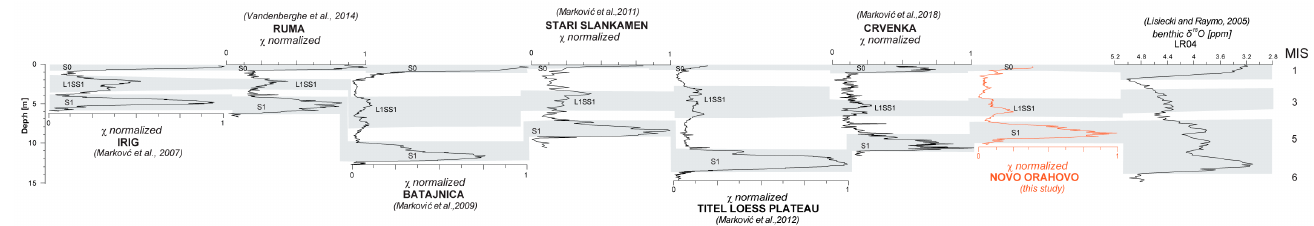
Figure 6. Relationship between low-field MS normalized records of loess–paleosol sequences Irig (Markovic et al., 2007) [19], Ruma (Vandenberghe et al., 2014) [8], Stari Slankamen (Markovi ć et al., 2011) [63], Batajnica (Markovi ć et al., 2009) [64], Titel loess plateau (Markovi ć et al., 2012) [65], and Crvenka (Markovi ć et al., 2018) [22] in the Vojvodina region and the Novo Orahovo loess sequence plotted on a depth scale. They are correlated with the LR04 paleoclimatic stack model of Lisiecki and Raymo (2005) [66].